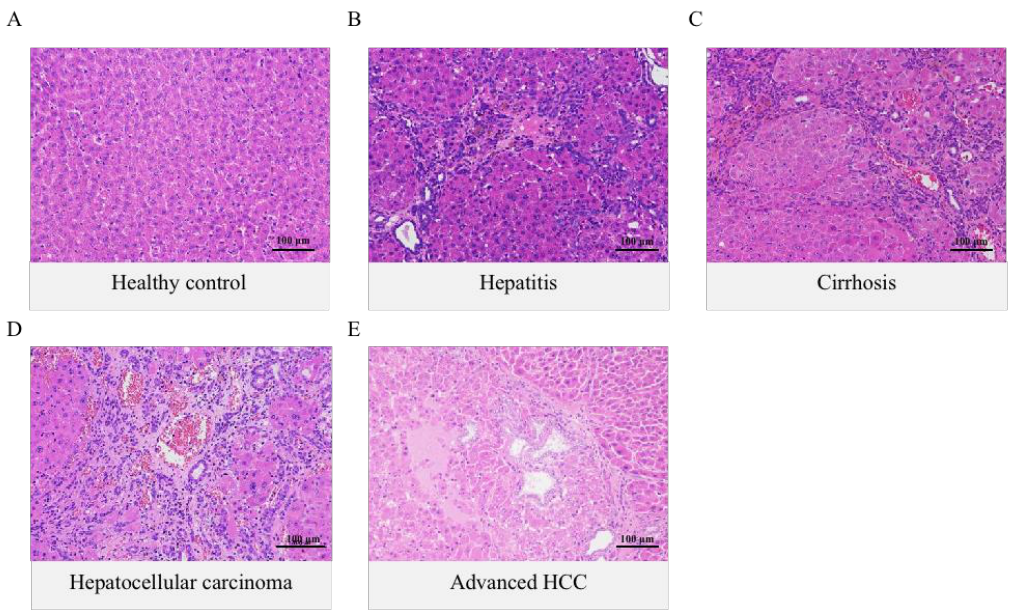
Figure 1. Histological examination of the liver in DEN-induced HCC rats during the inflammation- cancer transformation process. ( A ) The healthy control group showed a normal arrangement of liver cells and a regular structure of liver lobules. ( B – E ) Representative micrographs of liver tissue sections at various carcinogenic stages (H & E stain, × 200).